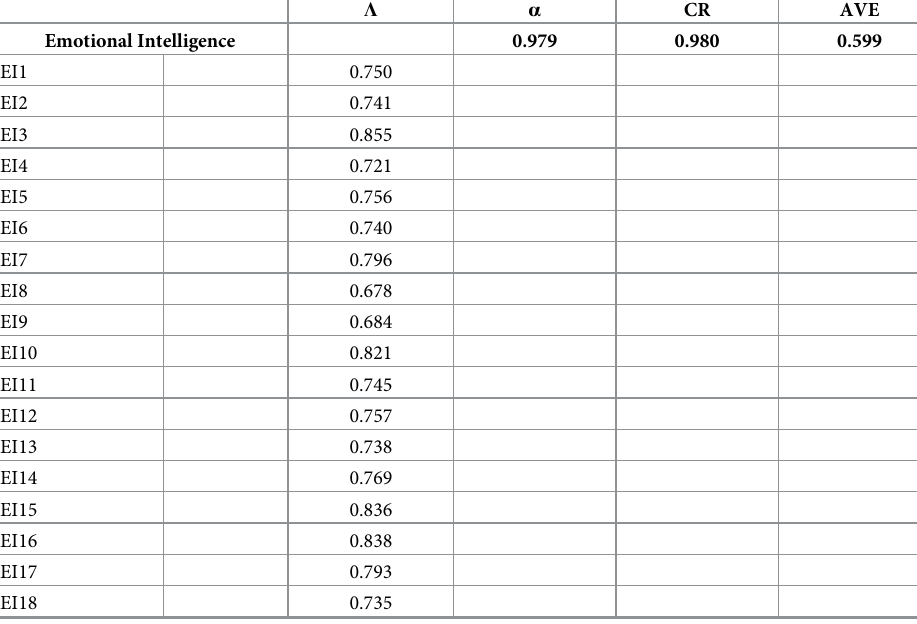
Table 2. Item loadings, reliability and convergent